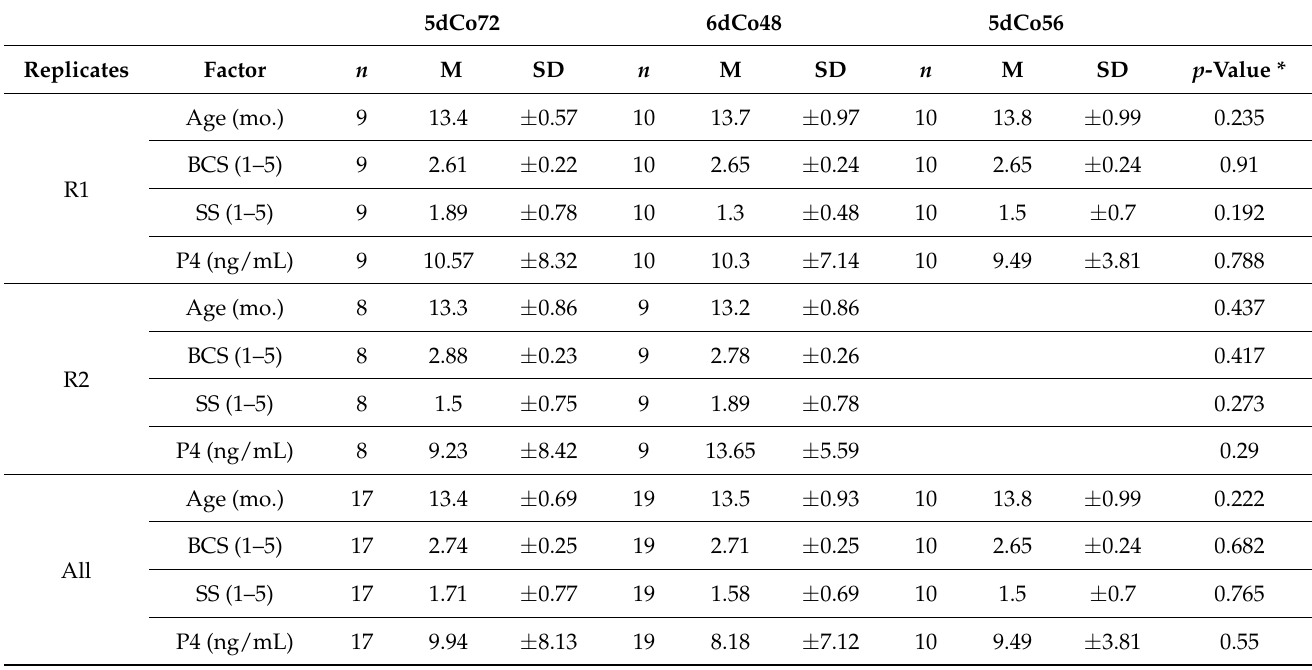
Table 1. Characteristics of dairy heifers included in experiment 1, by fixed-time AI experimental protocols. 5dCo72 6dCo48 5dCo56